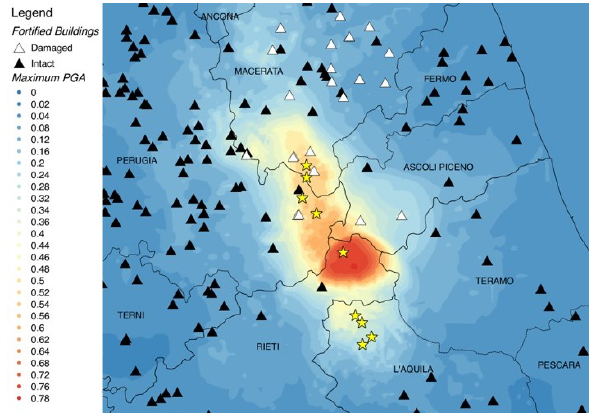
Figure 6. Interpolation of the pga’s maximum values of the seismic sequence that hit Central Italy since August 2016